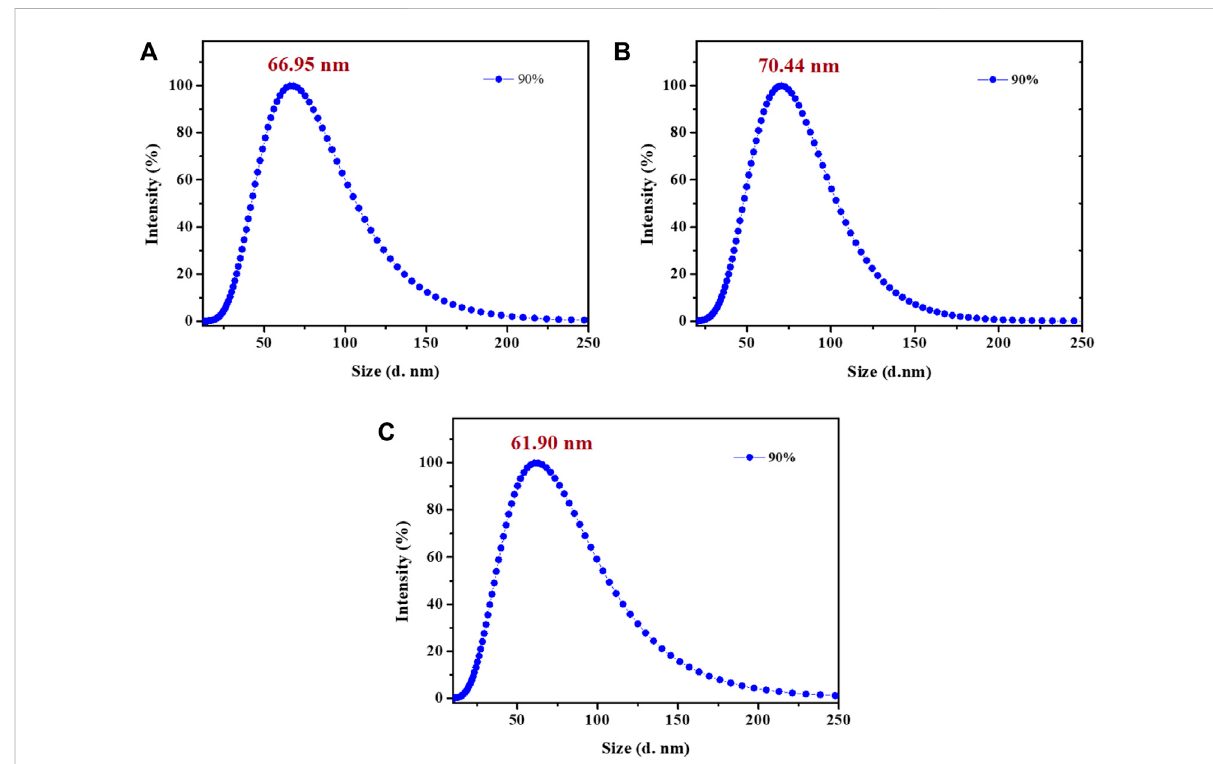
FIGURE 3 Size distribution curves of 1 (A) , 2 (B) and 3 (C) in DMF-water mixtures with 90% volume fraction of water ( E x : 365 nm; c : 2.0 × 10 – 5 mol L − 1